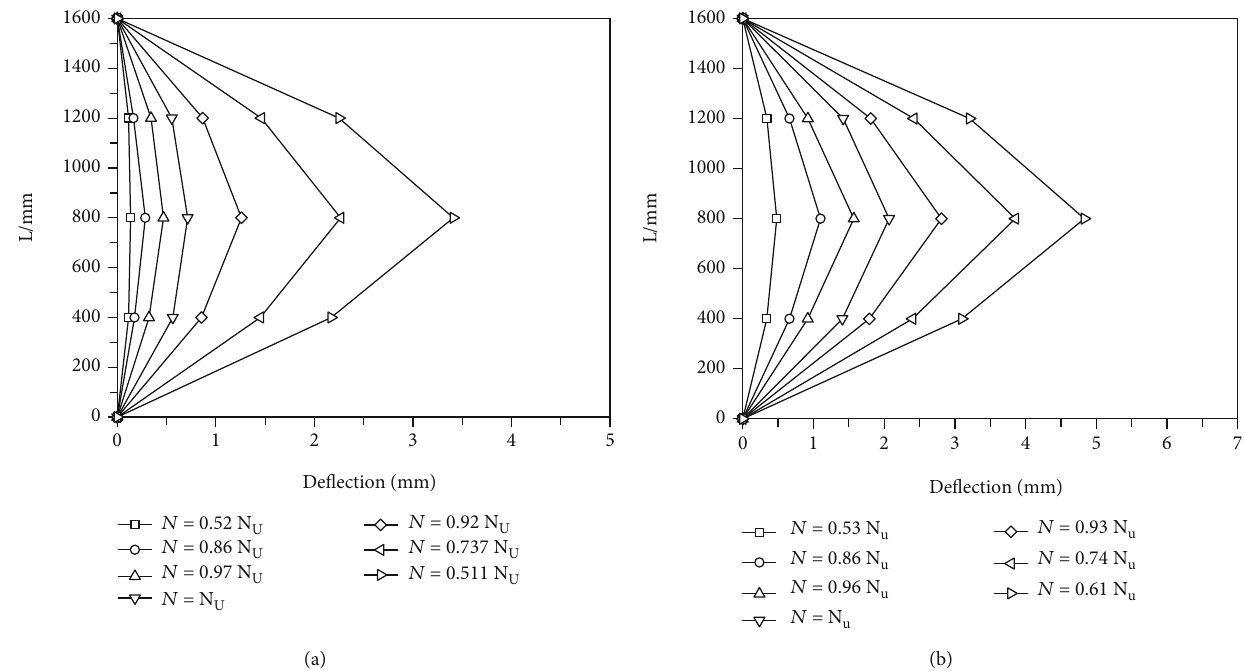
Figure 6: (a) 1600mm axial compression specimen. (b)1600 mm eccentric compression